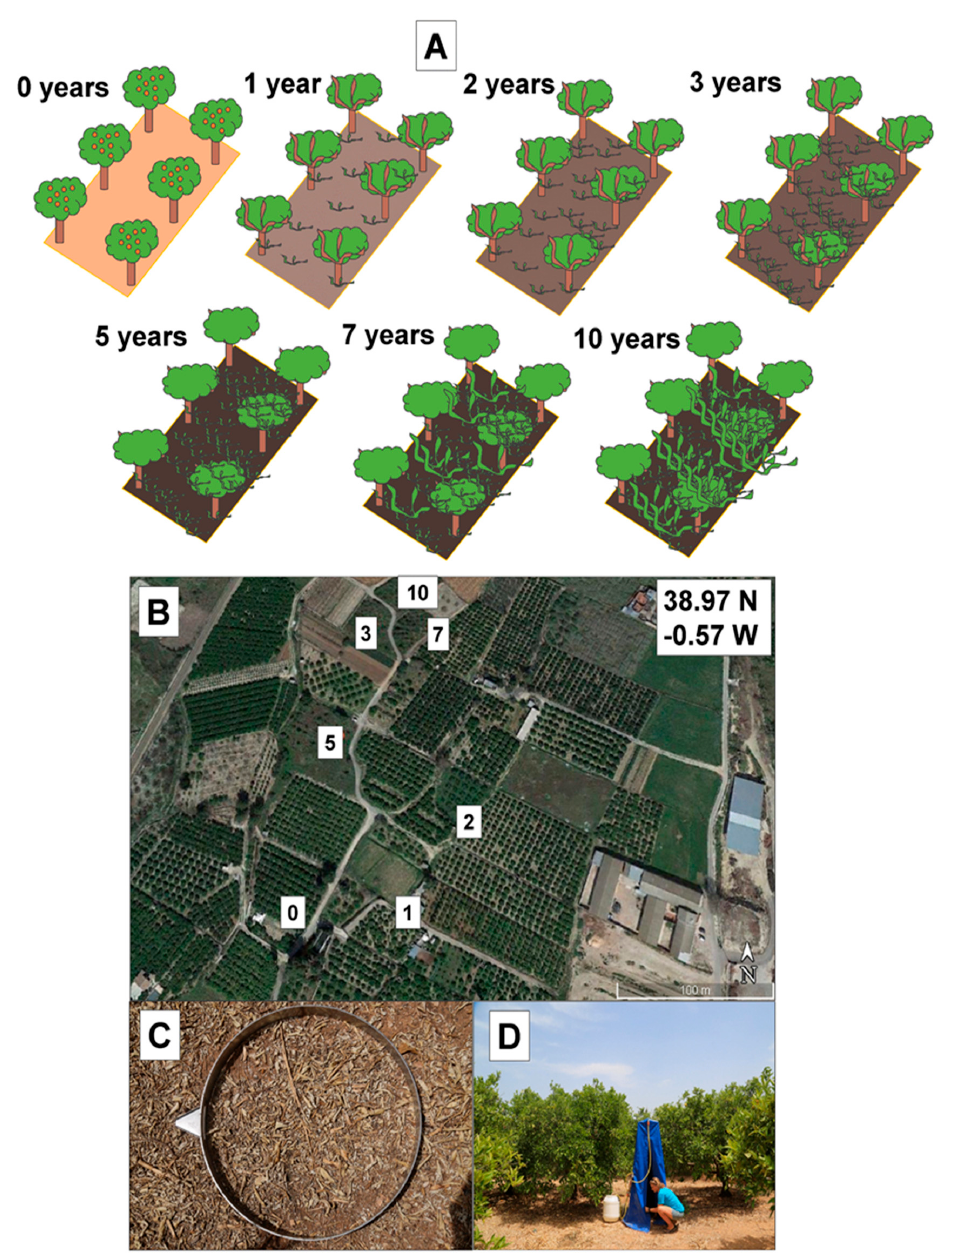
Figure 1. Scheme of the study plots ( A ), localization of the experimental fields ( B ), ring plot in the active farm ( C ), and field campaign ( D ).